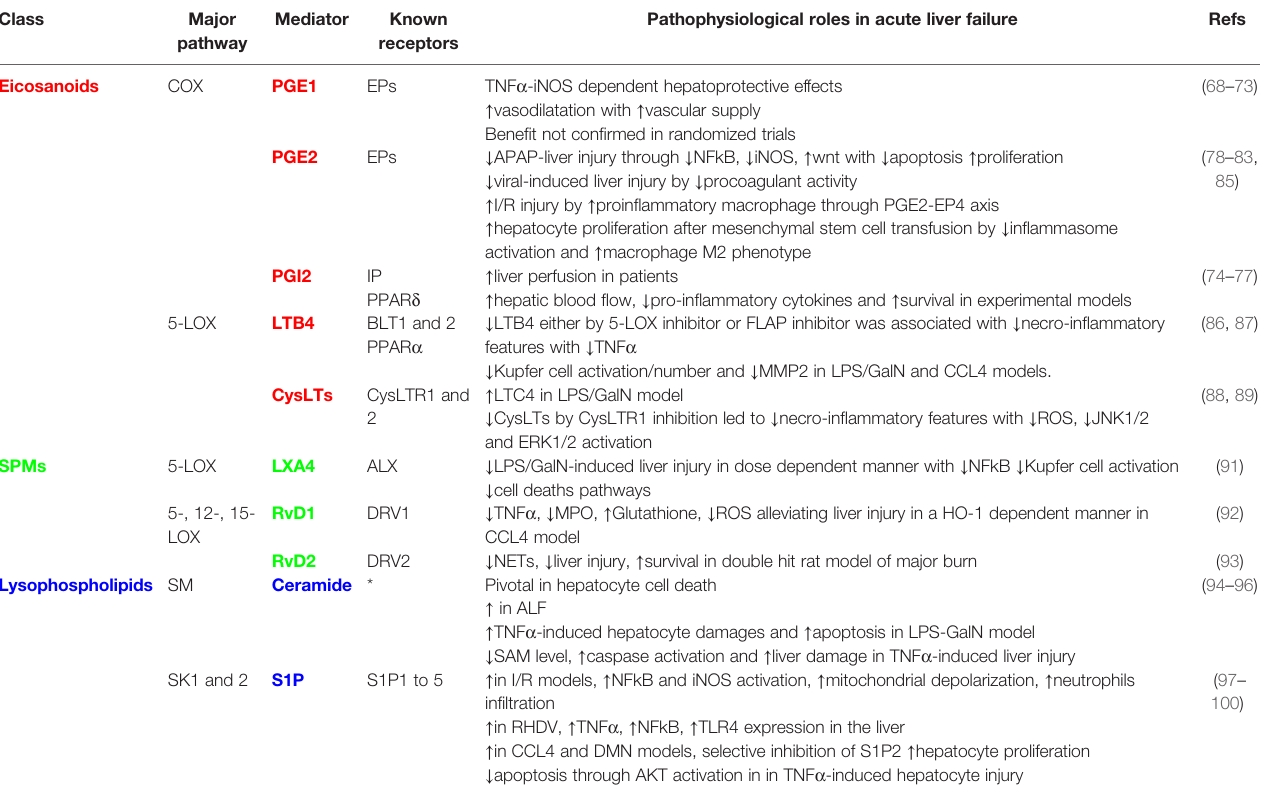
TABLE 1 | Eicosanoids, specialized pro-resolving mediators (SPMs) and lysophospholipids and their known pathways involved in acute liver